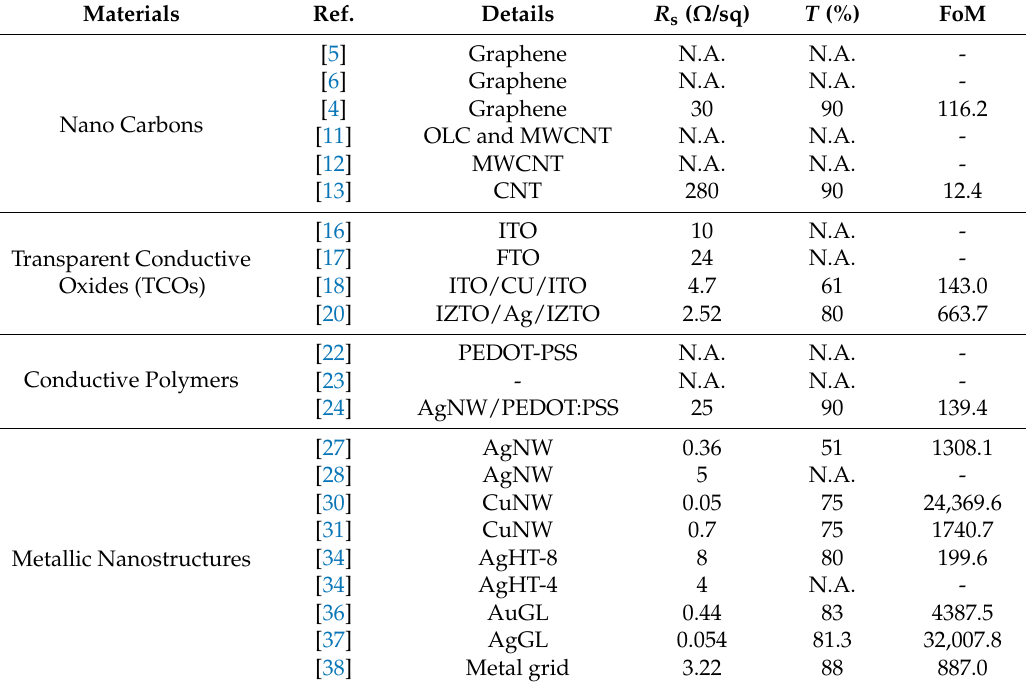
Table 1. R S - T performance parameters of transparent conductive films